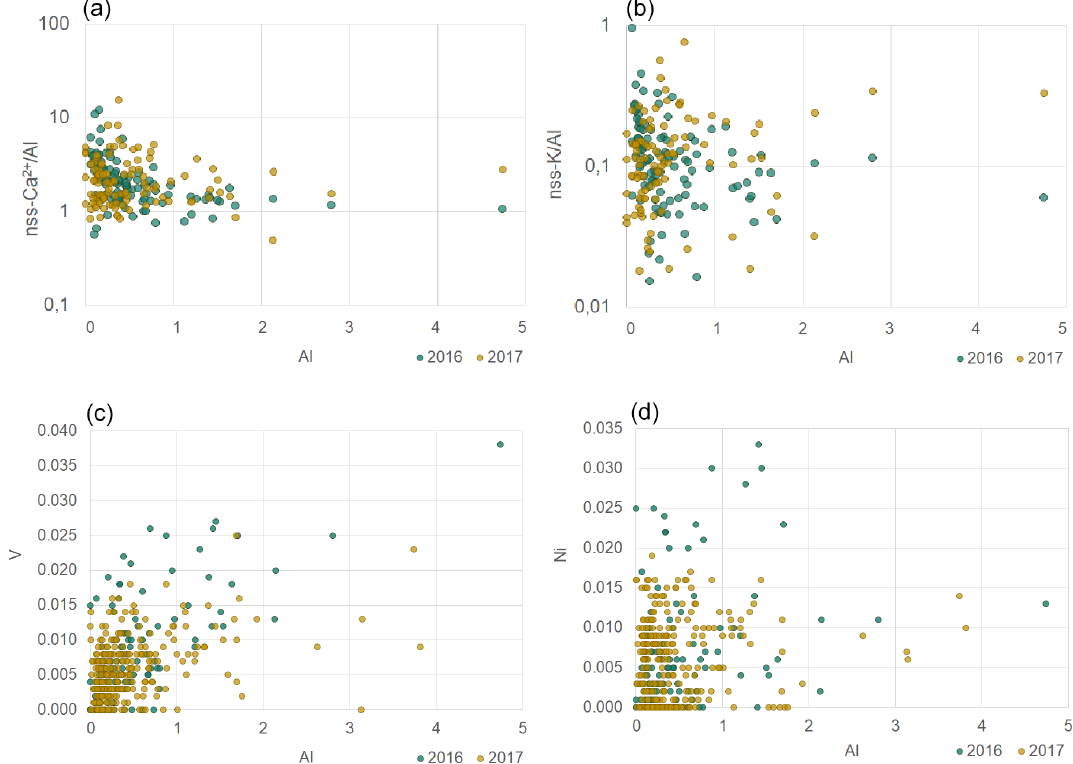
Figure 7. Scatterplots of nss-Ca 2 + / Al (a) , nss-K + / Al (b) , V (c) and Ni (d) ratios to Al for 2016 (blue) and 2017 (orange). Concentrations are expressed in µgm − 3 . Note the logarithmic y axes in the top